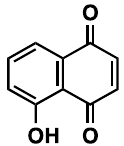
Figure 1. The chemical structure of juglone (5-hydroxy-1,4-naphthoquinone).